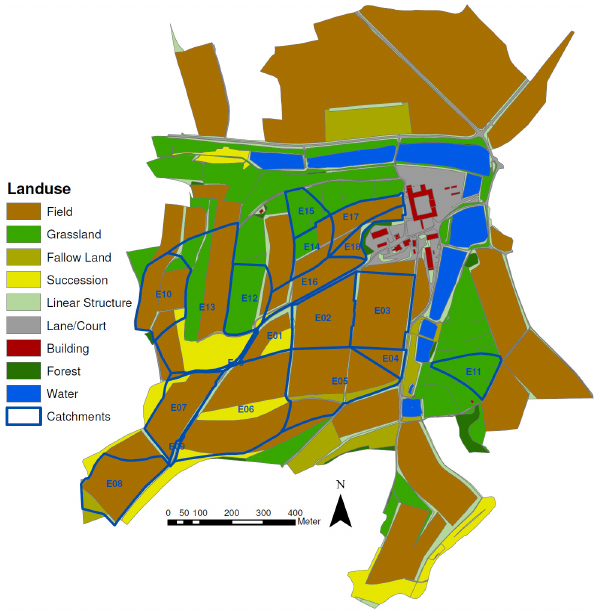
Figure 3: Land‐use and Delineation of Catchments in the Research Farm Scheyern 2 Fig. 3. Land-use and delineation of catchments in the research farm